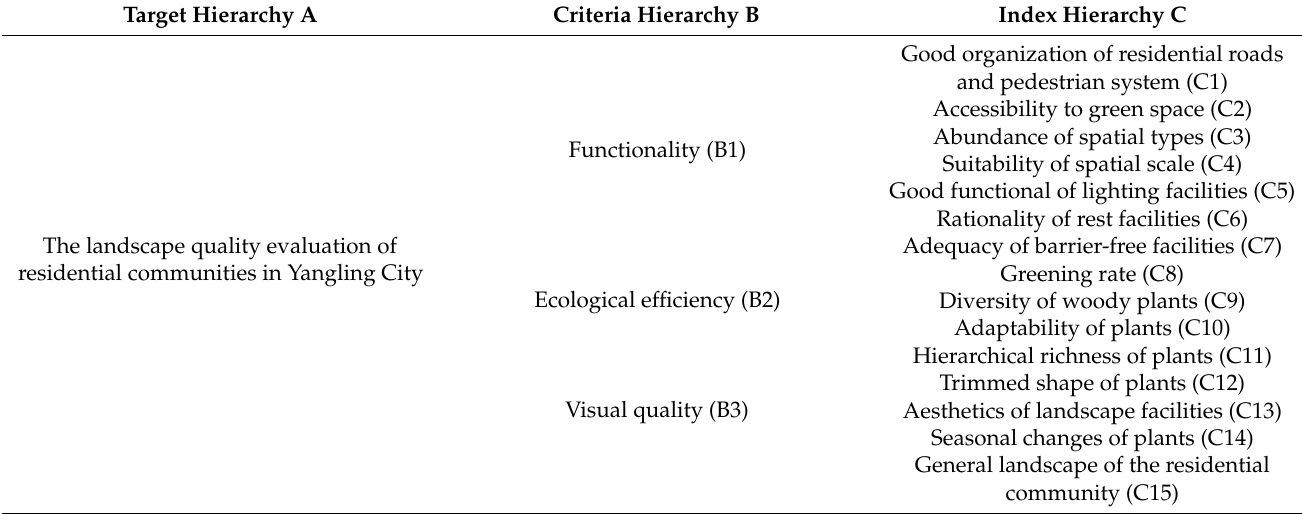
Table 1. The landscape quality evaluation